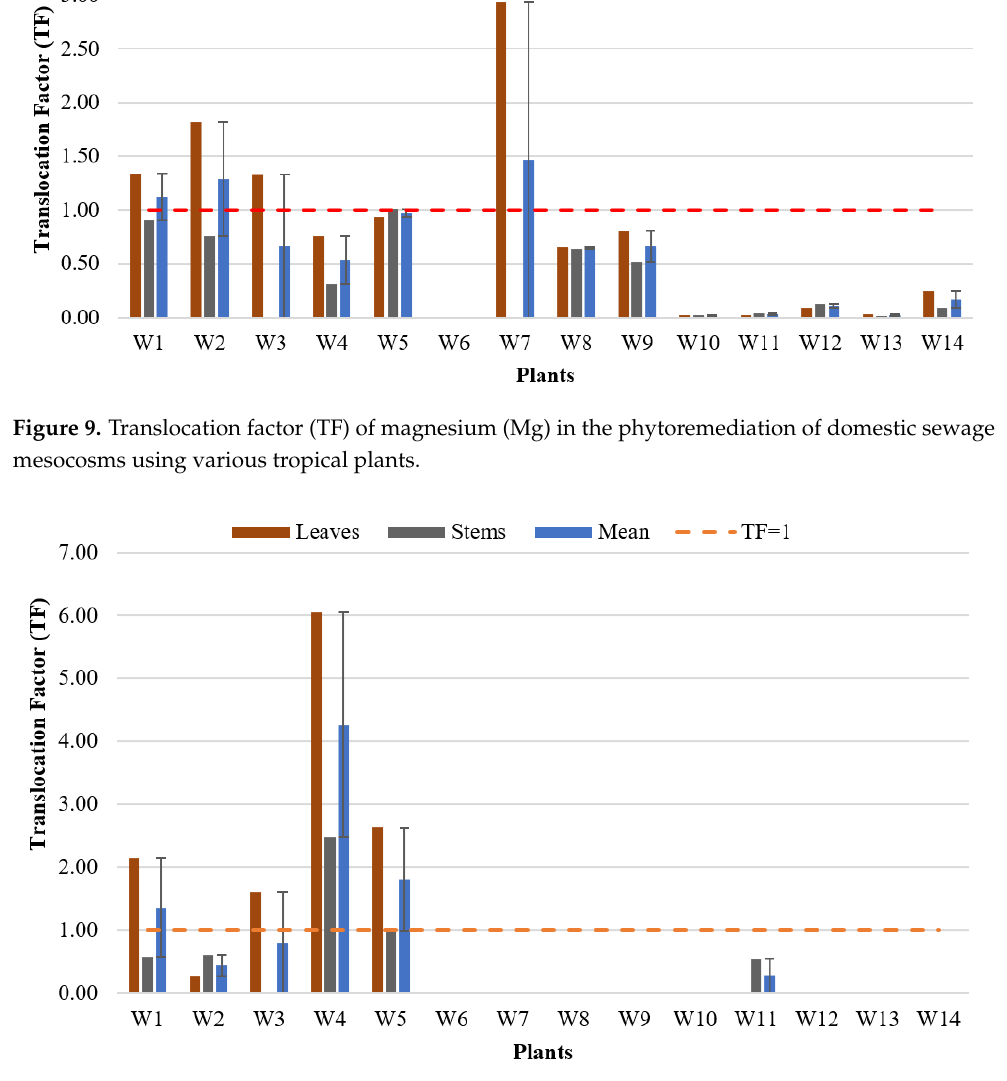
Figure 10. Translocation factor (TF) of manganese (Mn) in the phytoremediation of domestic sewage mesocosms using various tropical plants.